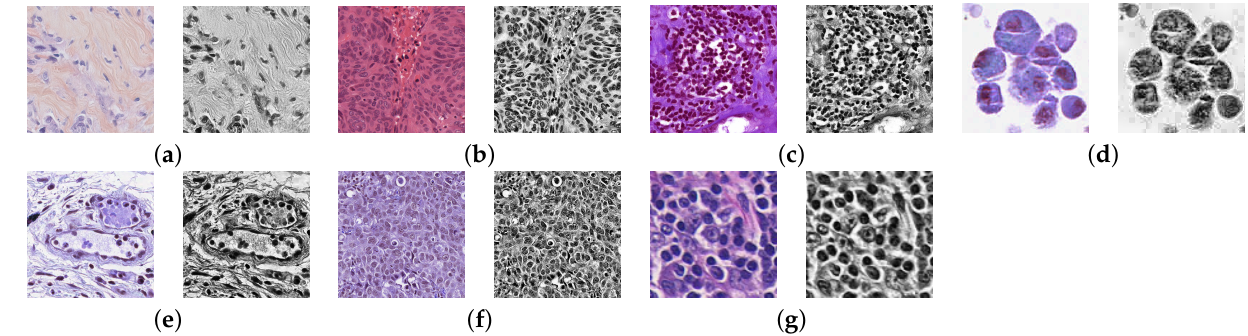
Figure 3. Sample images and corresponding pre-processed images from the datasets: ( a ) TNBC. ( b ) MoNuSeg. ( c ) MoNuSAC-L. ( d ) MoNuSAC-M. ( e ) MoNuSAC-N. ( f ) MoNuSAC-E. ( g )